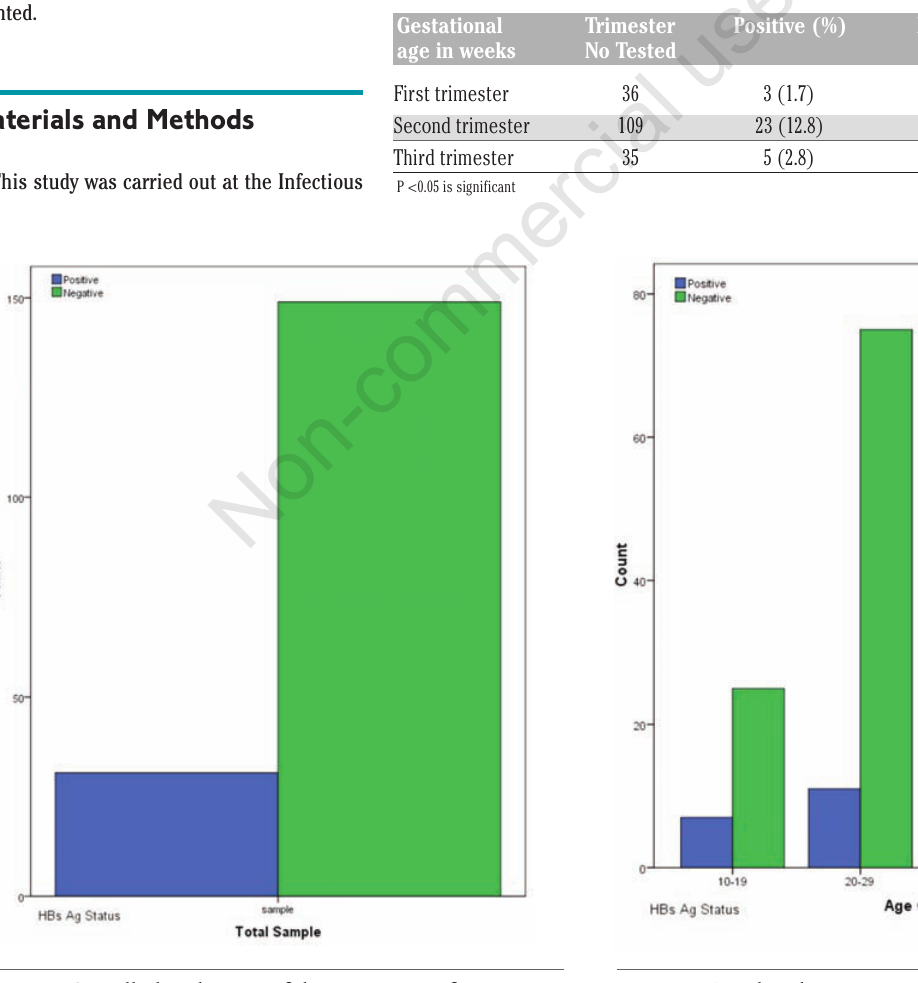
Figure 2. Age distribution as seroprevalence of hepatitis B sur- face antigen among pregnant